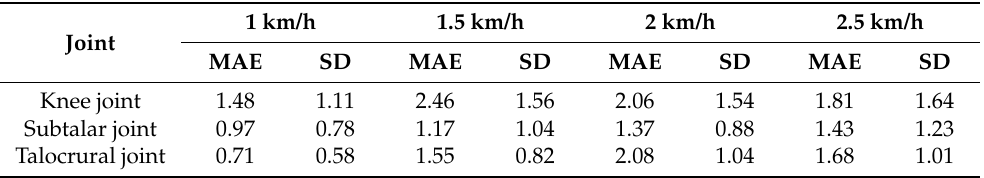
Table 7. The mean absolute error (MAE) and standard deviation (SD) of real-time angle estimation according to the walking speed.